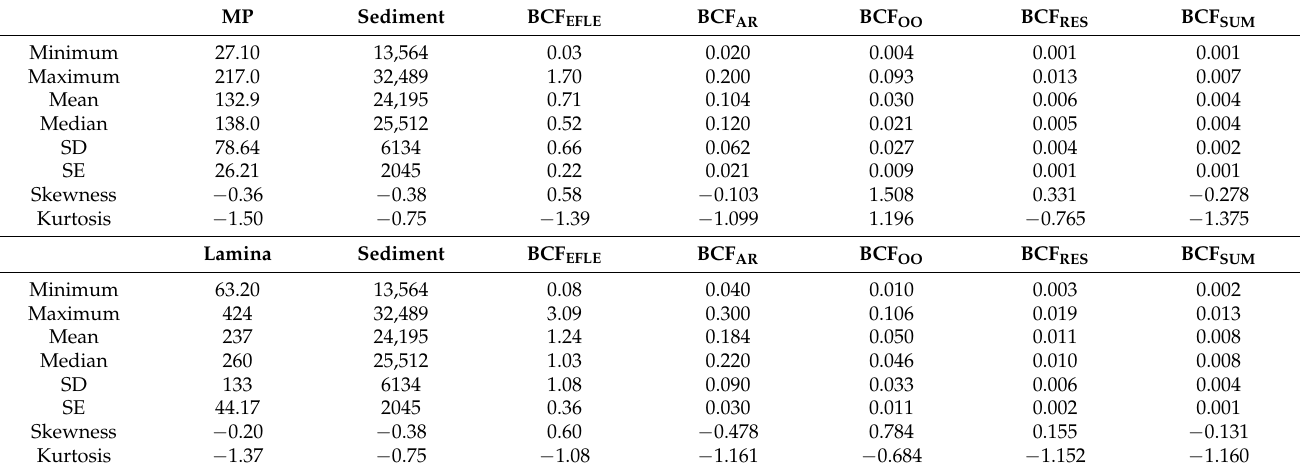
Table 3. Overall statistics of Fe concentrations (mg/kg dry weight) in the midrib plus petiole (MP) and lamina of Rhizophora apiculata , with their habitat geochemical fractions of sediments and their bioconcentration factor (BCF) values, collected from nine sampling sites in the mangrove areas of Sepang and Lukut. N = 9.